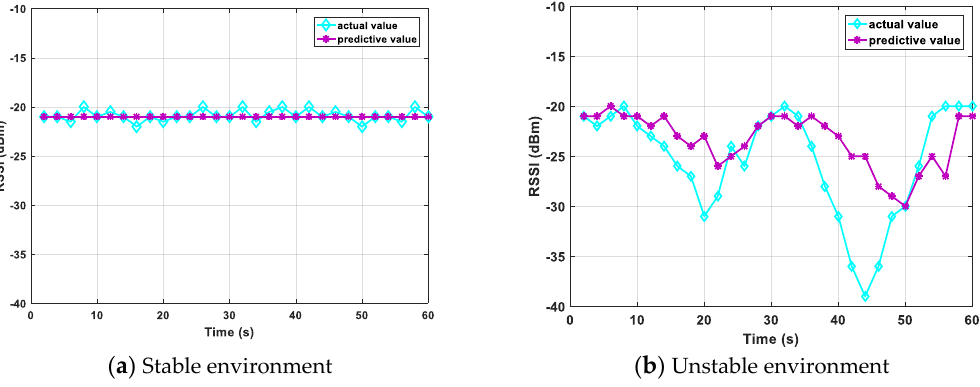
Figure 10. Predictive effect of RSSI.